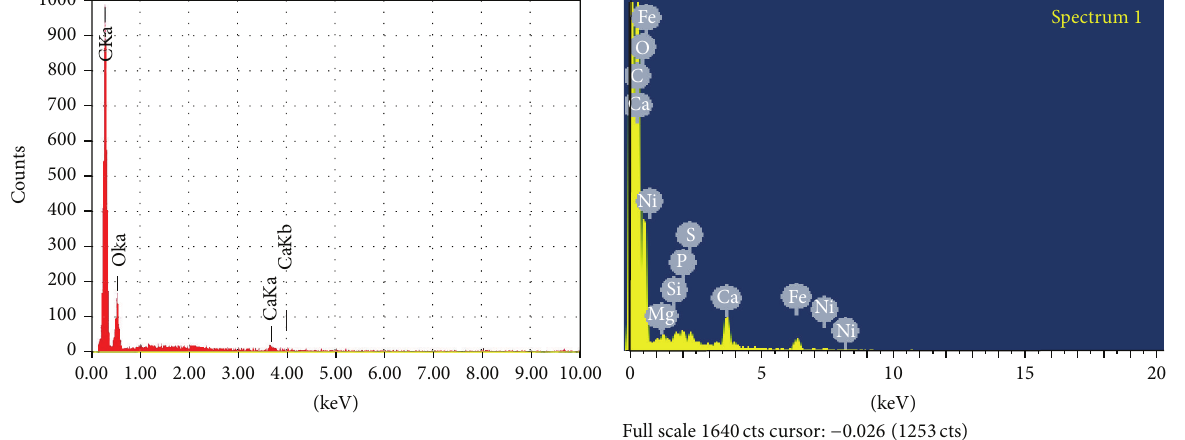
Figure 4: EDAX analysis of TGAN and TGAN-Ni.